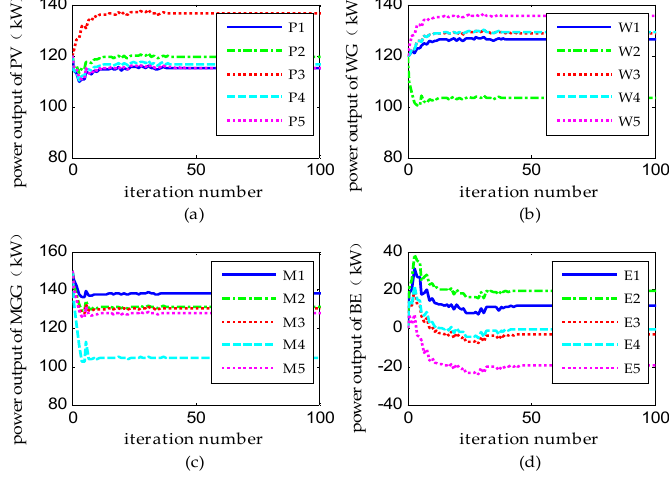
Figure 5. Dispatch results in Scenario B. ( a ) Power output of PV; ( b ) Power output of WG; ( c ) Power output of MGG; and ( d ) Power output of BE.